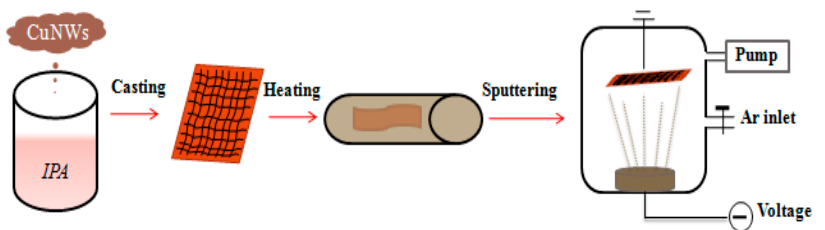
Figure 1. Schematic diagram of the preparation procedure for the Cu@Si core–shell nanowire thin films (CSNWFs).